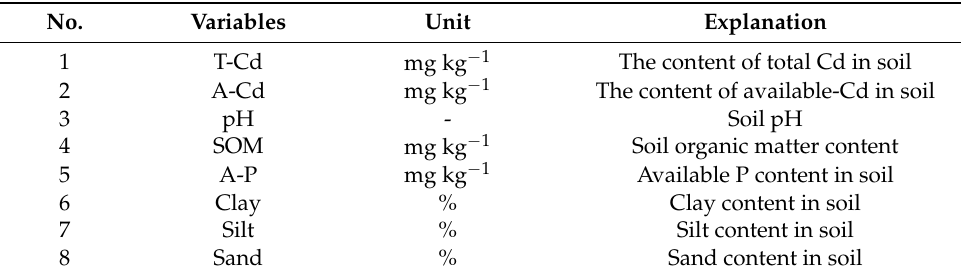
Table 1. T-Cd, A-Cd and their influencing factors in